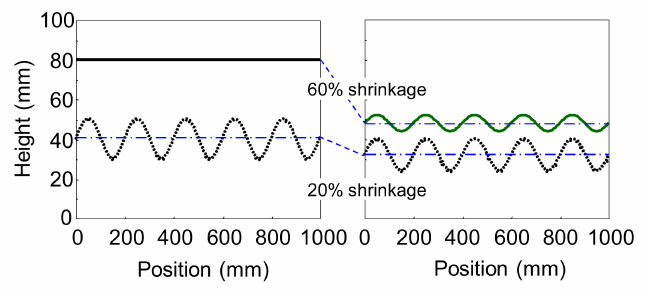
Figure 1. Schematic representation of telegraphing of interface waviness (shrinkage percentage between upper layer and lower layer is different).